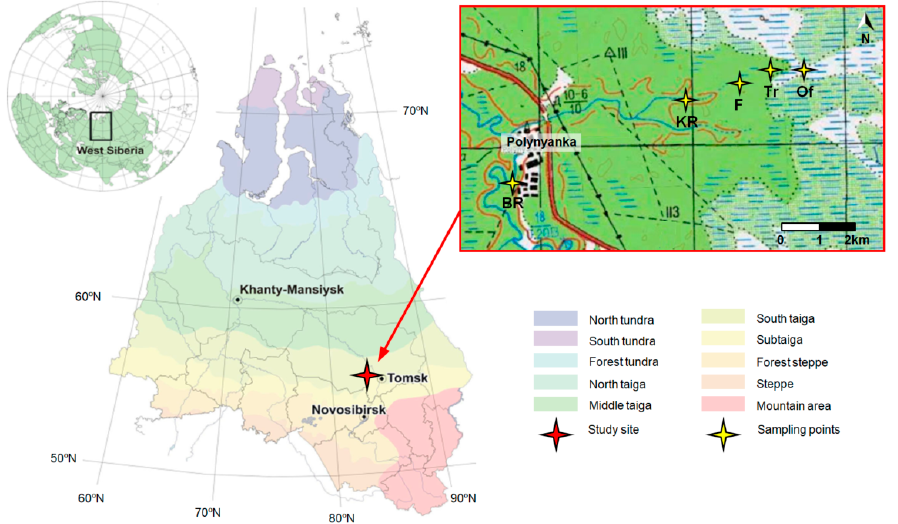
Figure 1. Map of the study site in the Western Siberian Lowland with study site (red asterisk) and sampling points along the aquatic continuum as shown by yellow asterisks: Of—open sedge-sphagnum fen; Tr—tall ryam (pine–shrub–sphagnum phytocenosis with high pine trees); F—waterlogged pine-birch forest; KR—Klyuch River (small mire stream); BR—Bakchar River. The territory of the northeastern part of the Great Vasyugan Mire, where our